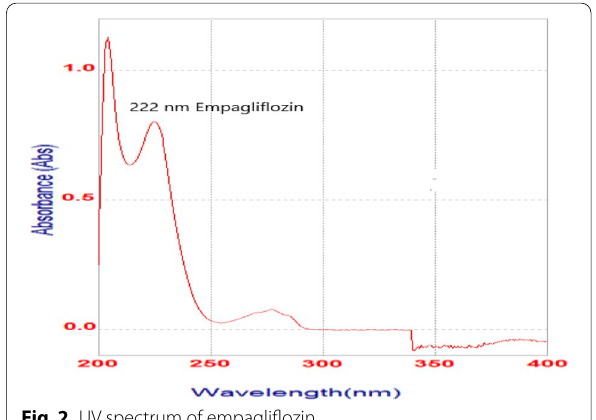
Fig. 2 UV spectrum of